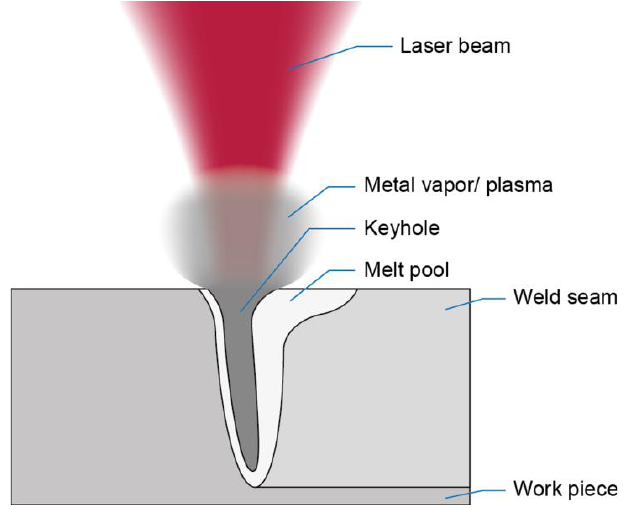
Figure 1. The schematic of melt pool shape and deep penetration welding [5].